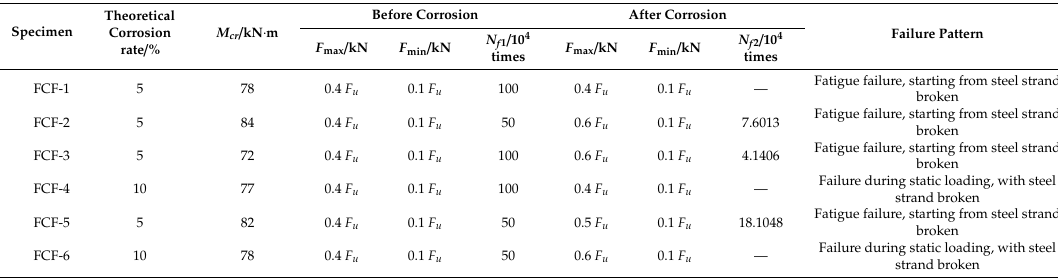
Table 3. Fatigue loading